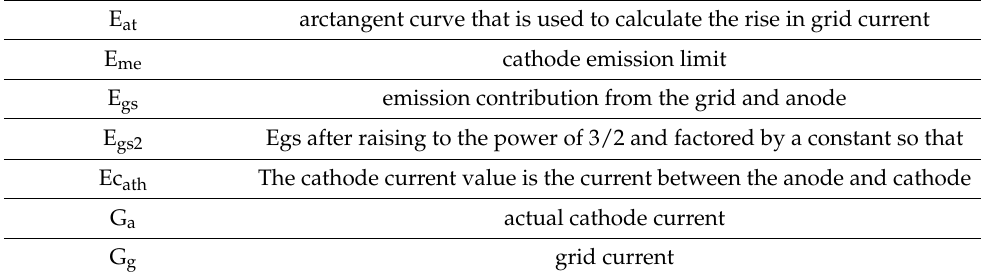
Figure 3. Graph of the dependence of anode current and grid current on grid voltage at constant anode voltage V a = 3000 V.